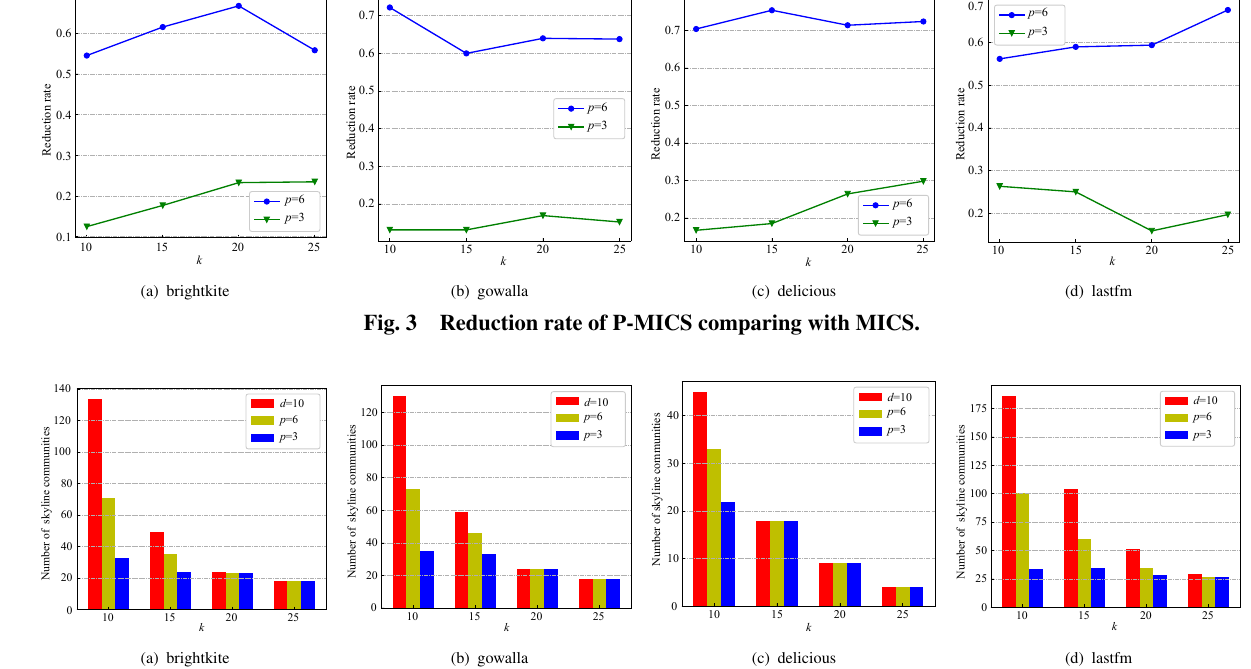
Fig. 4 Number of skyline communities found by MICS ( d DDD 10) and P-MICS ( p DDD 6 and p DDD